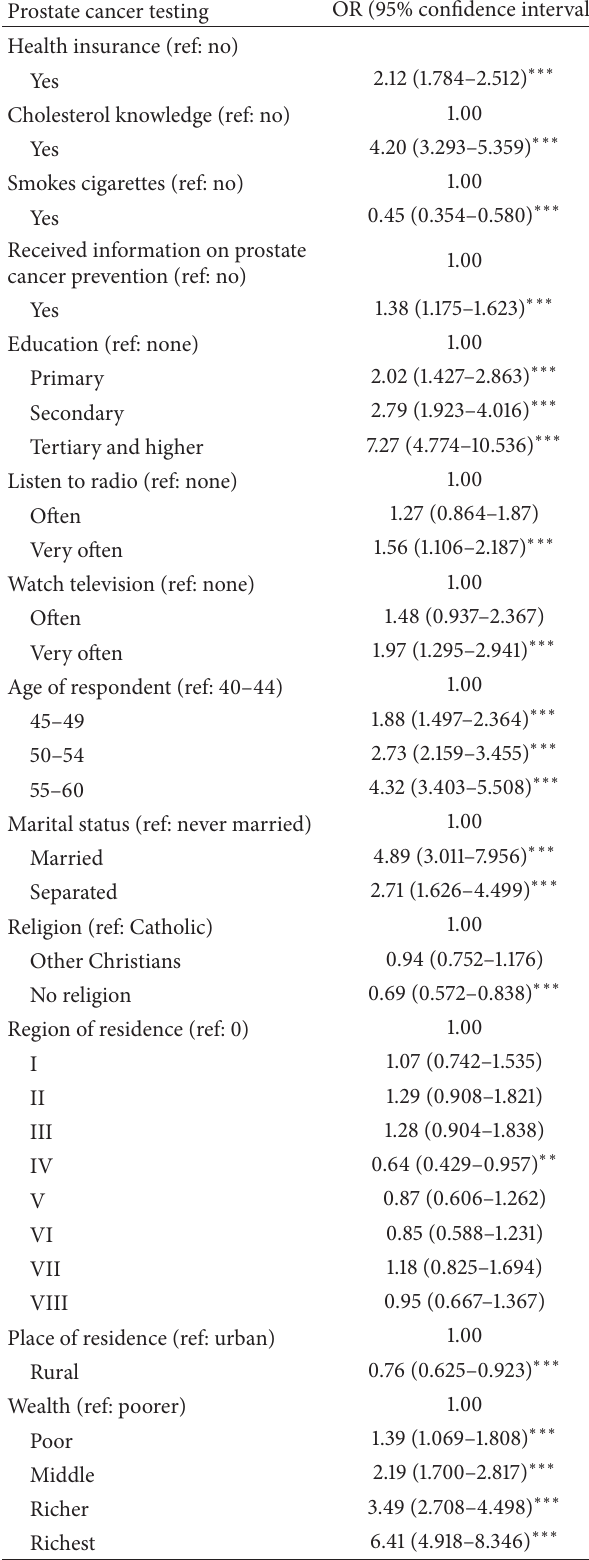
Table 2: Bivariate associations between independent variables and prostate cancer